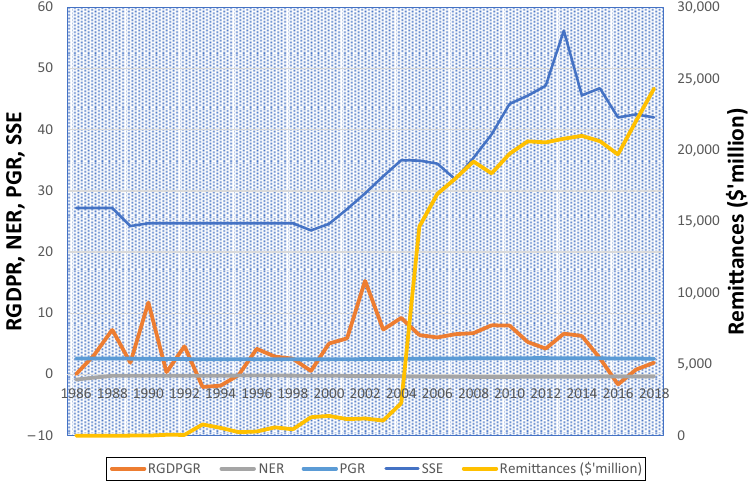
Figure 1. Trend of